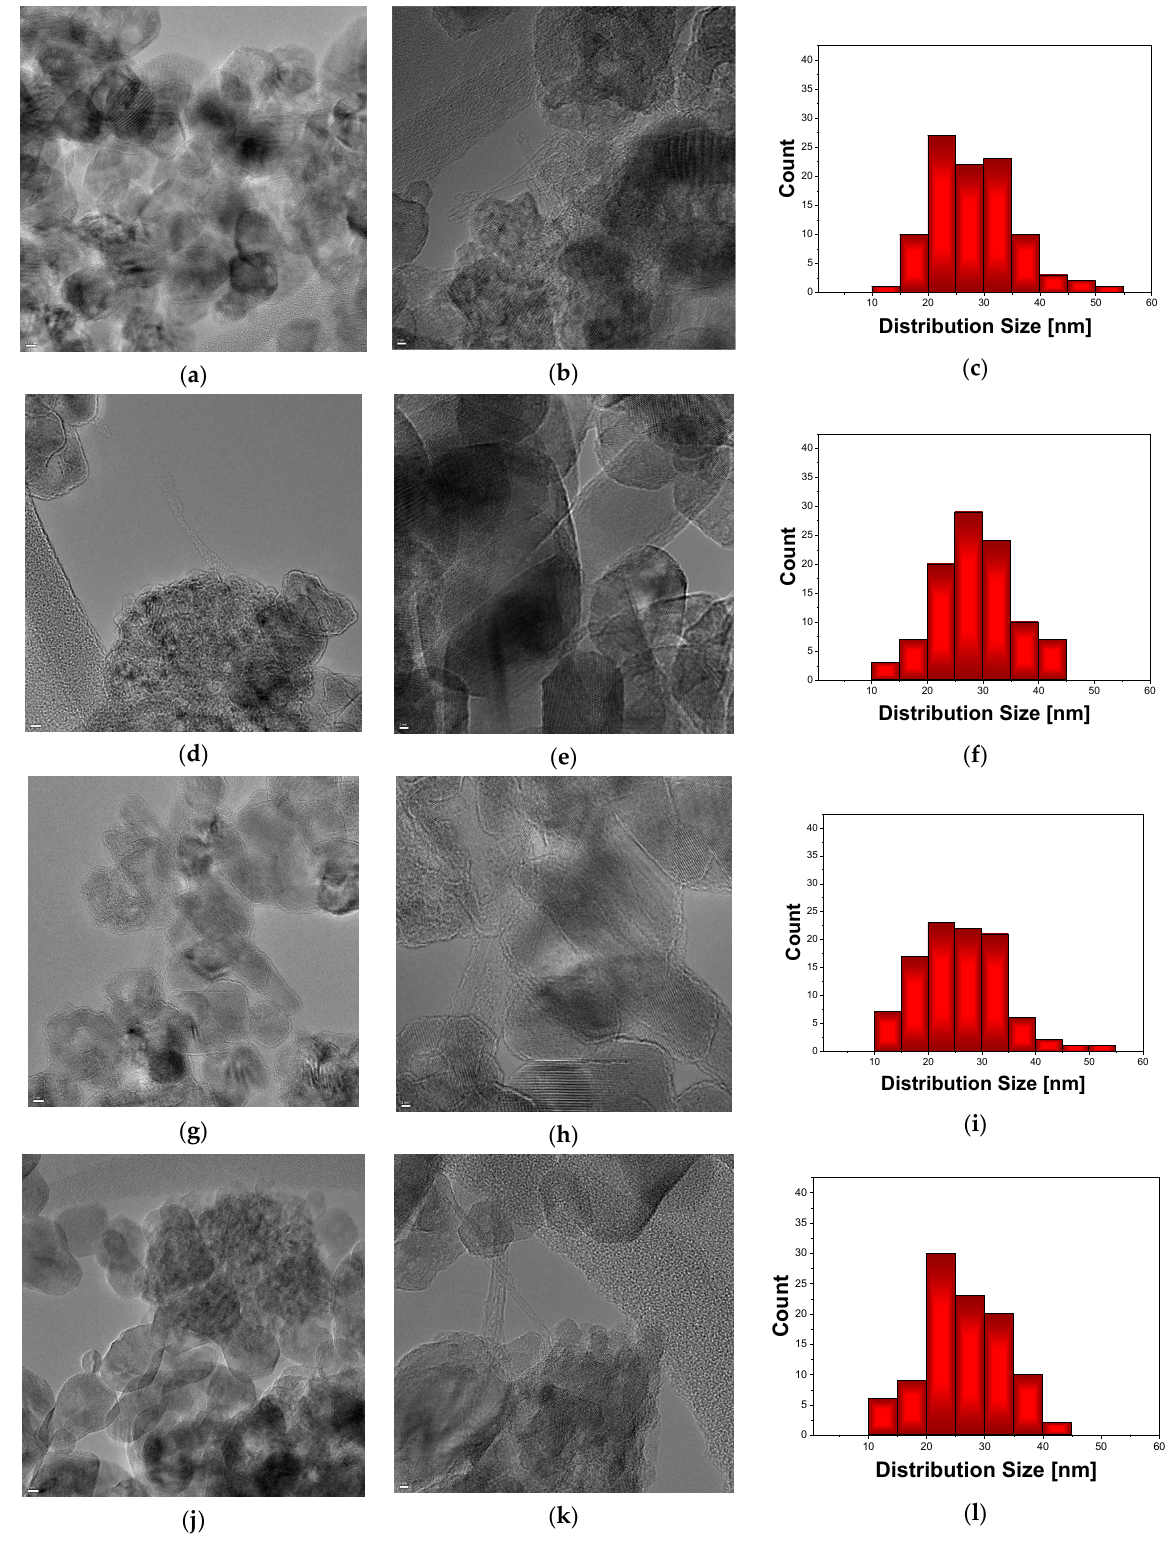
Figure 3. TEM images with the magnification 500 kX and 1M as well as the TiO 2 :N size distribution in the case of the samples of TiO 2 :N/SWNTs (S2 sample; a – c ) TiO 2 :N/DWNTs (D sample; d – f ), TiO 2 :N/MWNTs (M sample; g – i ) and TiO 2 :N/SWNTs-COOH (SC sample; j – l ).